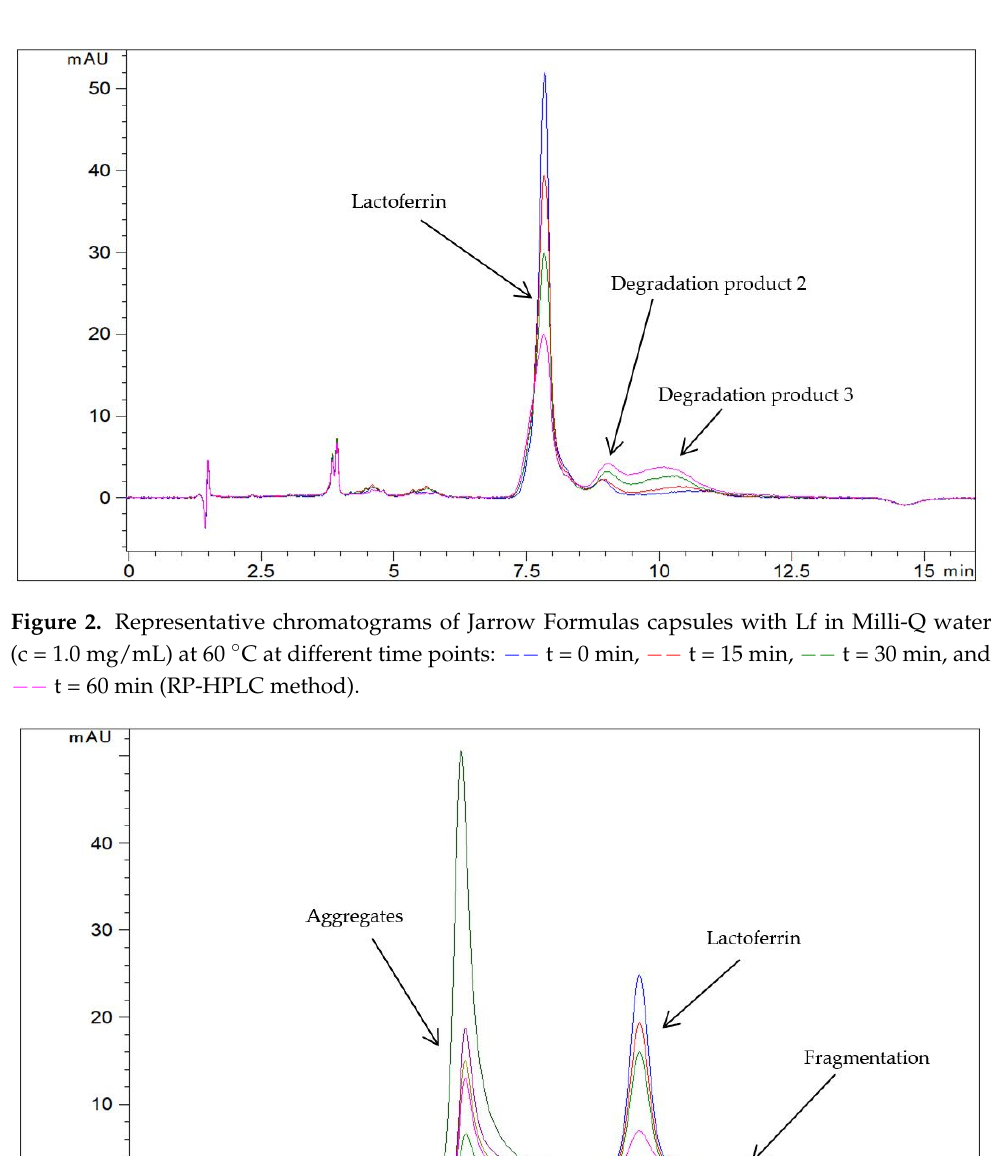
Figure 1. Representative chromatograms of solid Lf isolate sample 1 in Milli-Q water (c = 1.0 mg/mL) at 50 °C at different time points: −− t = 0 min, −− t = 15 min, −− t = 30 min, −− t = 60 min, −− t = 120 min, −− t = 240 min, and −− t = 24 h (RP- HPLC method).